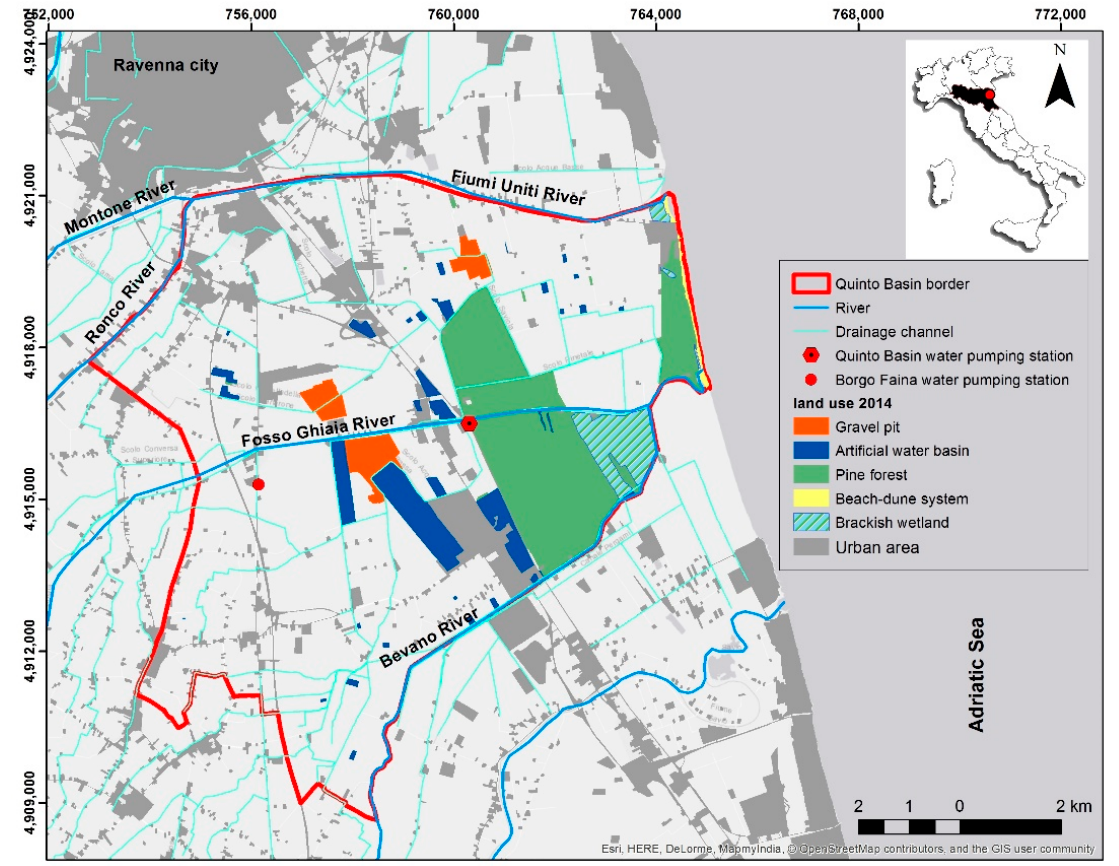
Figure 1. Location of the Quinto Basin study area, south of Ravenna (Italy). The Basin conveys its drainage water to the main pumping station, named Quinto Basin pumping station (about 5 km from the coastline), while a second one, named Borgo Faina , that was designed and is operated for safety reasons in the event of significant precipitation. This second pumping station routes water to the first one. (Map coordinate system: UTM-Zone 32-Northern Hemisphere).